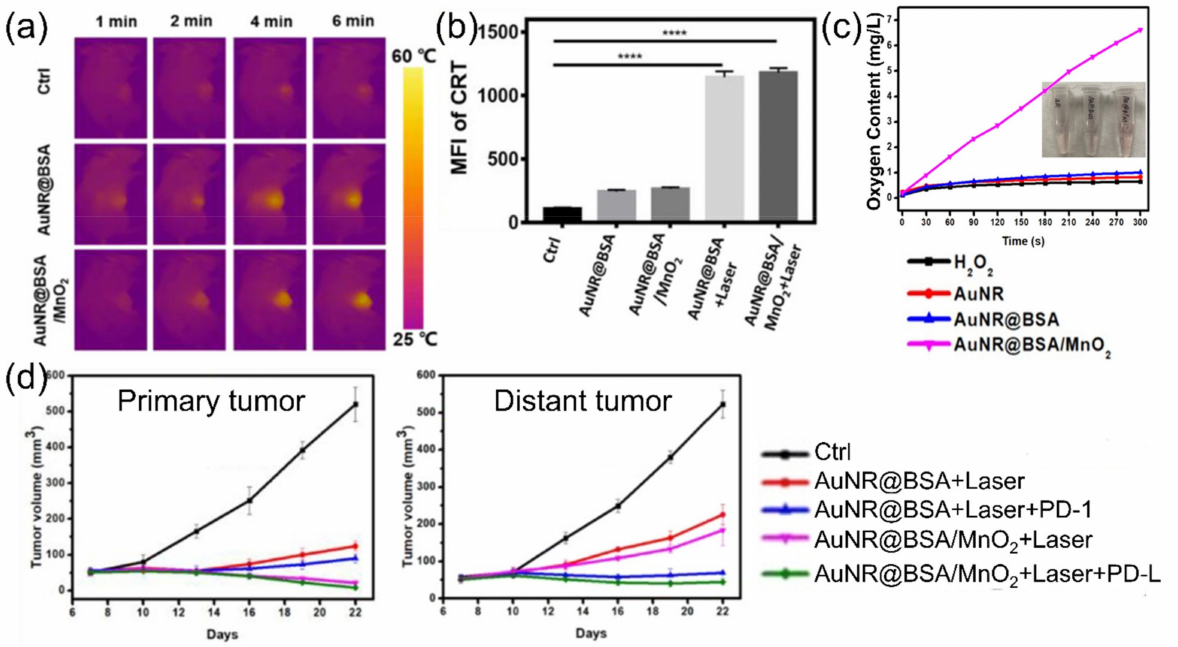
Figure 7. ( a ) Thermal images of 4T1 tumor area after laser irradiation; ( b ) expression of CRT after treatments (**** p < 0.0001); ( c ) oxygen generation curves from the decomposition of H 2 O 2 in the presence of the PTT agent AuNRs; ( d ) tumor growth curve of primary and distant tumor after treatments (BSA: bovine serum albumin, PD-1: immune checkpoint blockade). Figures are reproduced from ref. [116] with permission from Wiley-VCH